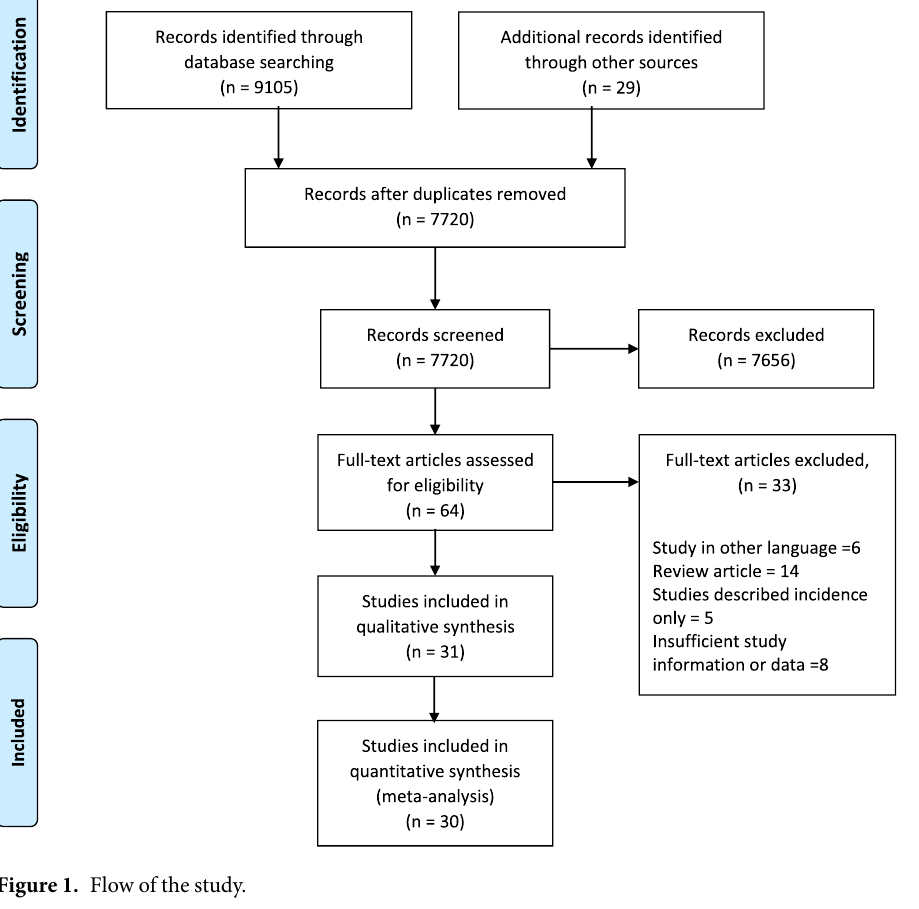
Figure 1. Flow of the